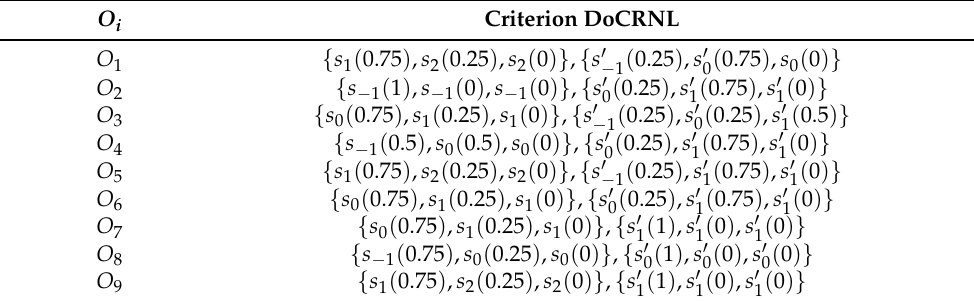
Table 12. Normalized qualitative matrix for criterion DoCRNL.